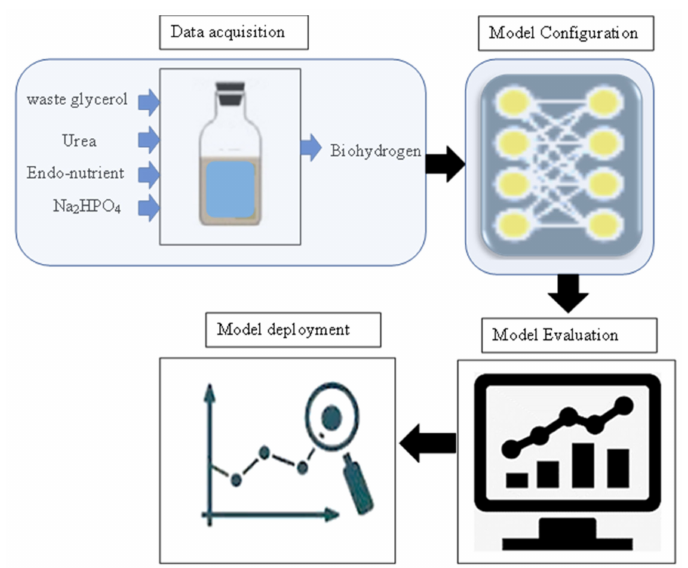
Figure 1. Overall process flow for the modeling of biohydrogen production from waste